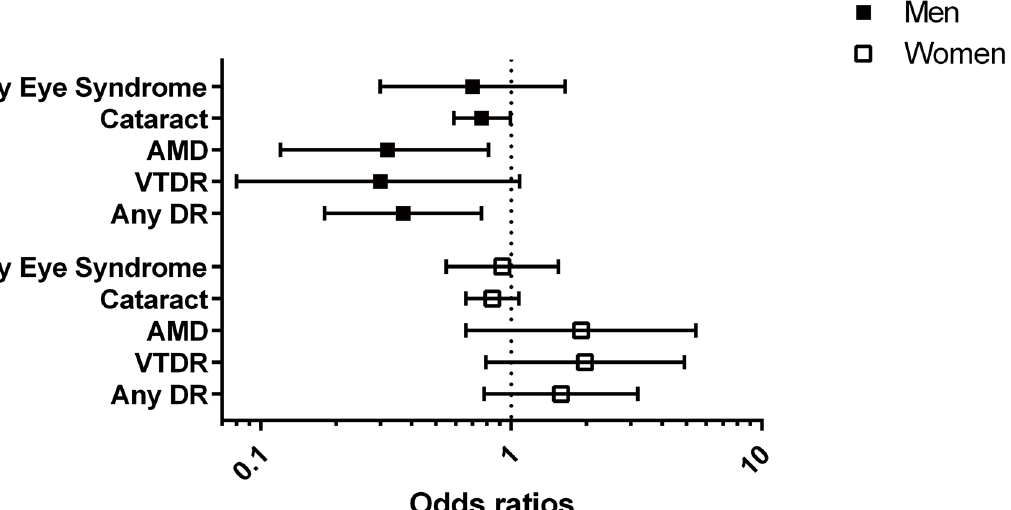
Fig 3. The comparison of odds ratios of dry eye syndrome (DES), cataract, age-related macular degeneration (AMD), any diabetic retinopathy (DR), and vision-threatening DR (VTDR) according to blood vitamin D levels (reference group = lowest vitamin D quintile